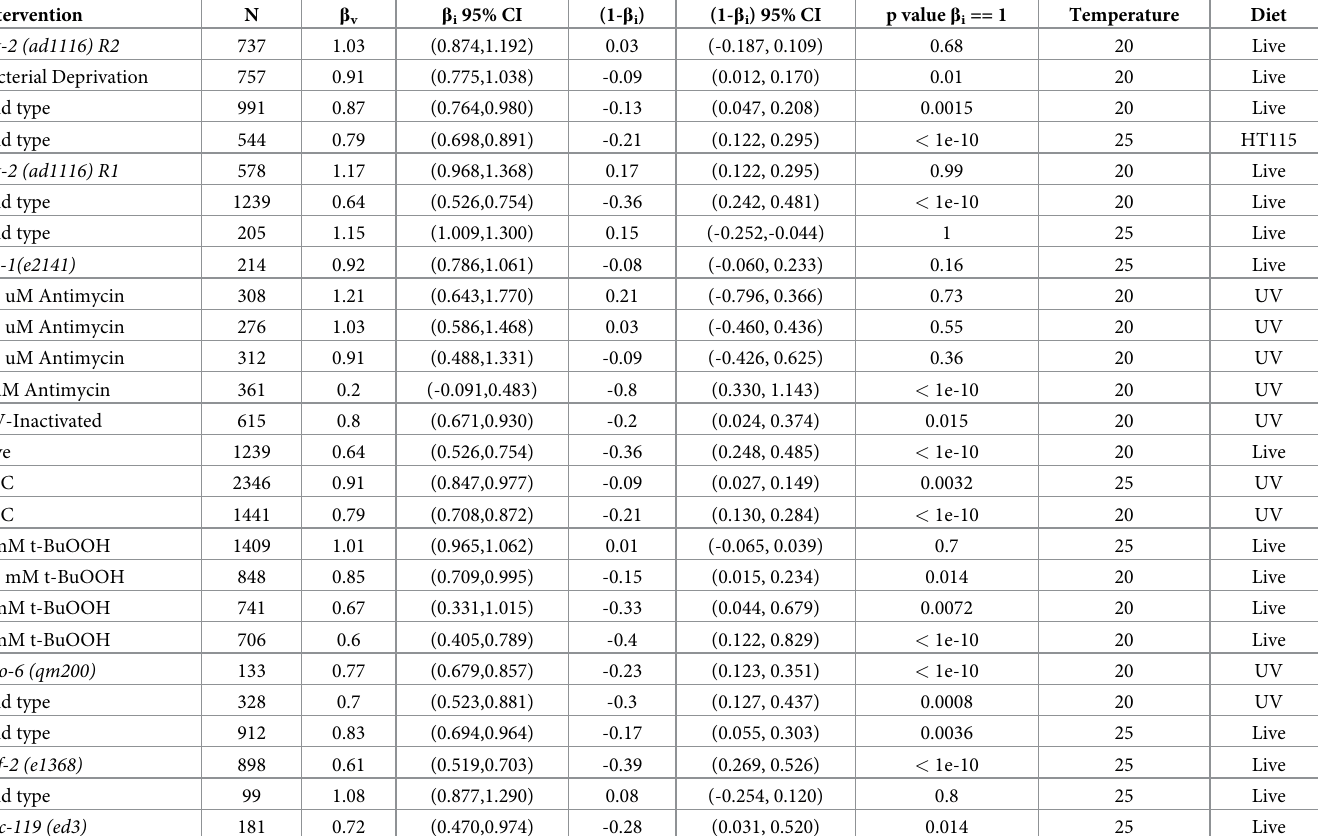
Table 1. The effect of interventions and mutations on the slope of the linear model relating VMC and death times. Parameter estimates of β v and the p-value testing the hypothesis (1- β v)! = 0. Confidence intervals and p-values were obtained via bootstrapping.